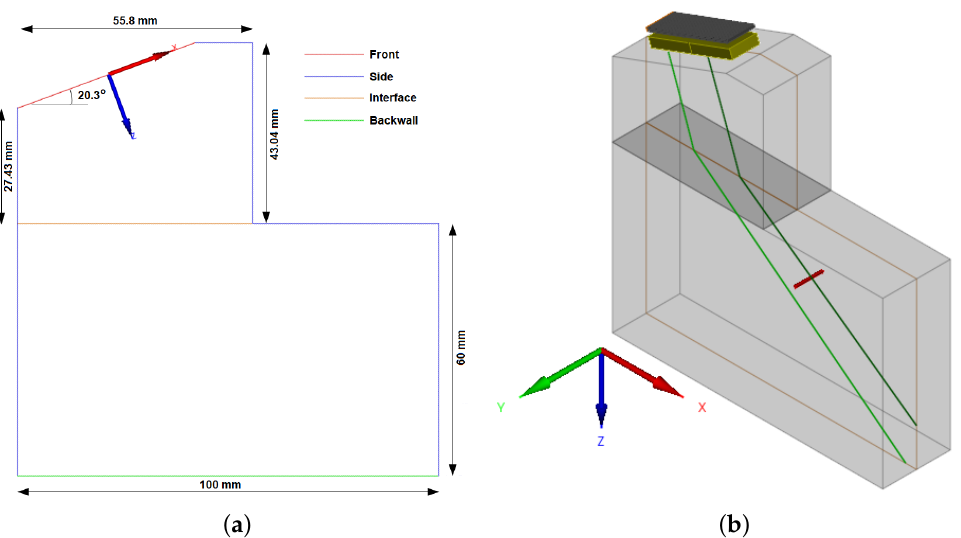
Figure 6. Extended test body, formed by the wedge and the metal block, configured in software CIVA to make it possible to simulate ultrasonic NDT subjects to temperature gradients. ( a ) 2D CAD and ( b ) test body resulting from the extrusion of the 2D